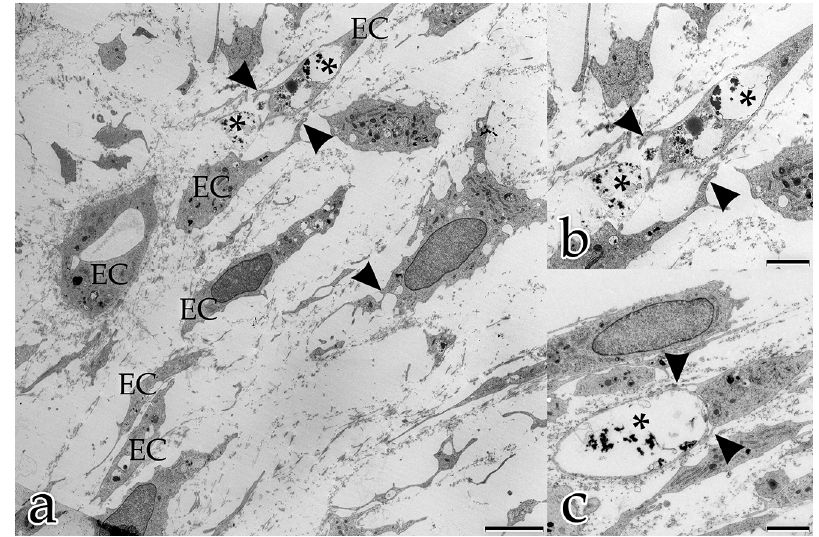
Figure 2. Coculture of ECs with FBs after 10 days: ( a – c ) ECs organize into chains that align with the main orientation of the ECM. Cells are connected to each other by their polar cellular protrusions (arrowheads); ( a ) angiogenic ECs use the ECM as guiding structures to line up into chains; ( b ) magnification of ( a ); ( c ) endothelial stalk cells fuse into a tube, with lumenization by fusion of intracellular and extracellular vacuoles, respectively (asterisks). ( a ) Bar: 5.000 nm, ( b , c ) Bar: 2.500 nm.